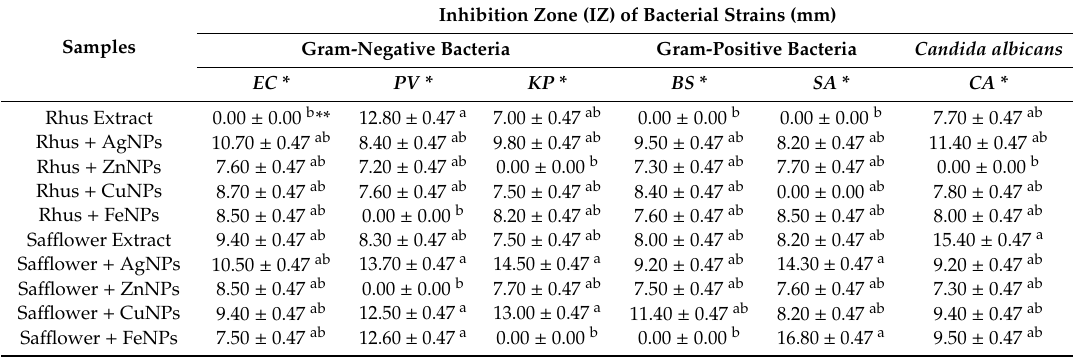
Table 1. Antimicrobial activities of rhus and sa ffl ower extracts and their nanoparticles using agar disc di ff usion technique at 35 µ g mL − 1 after 24